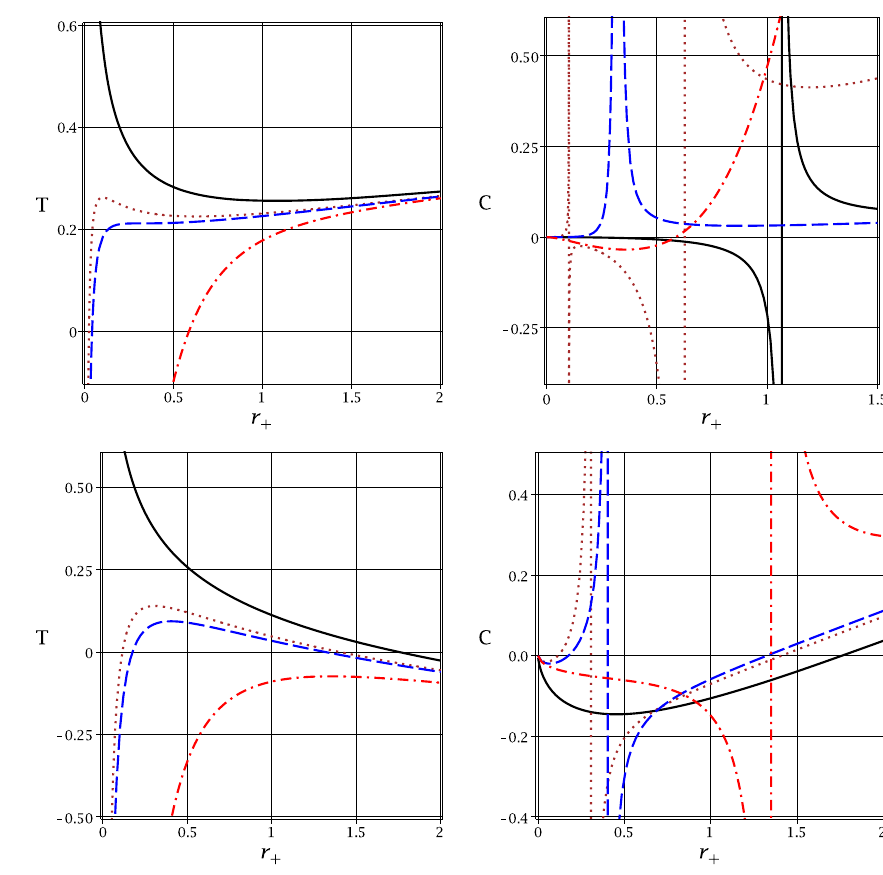
Fig. 6 T (left panels) and C (right panels) versus r + for k = 1, m = 5, (cid:16) = − 1, b = 1, q = 1, f (ε) = g (ε) = 0 . 9, β = 0 (continuous line), β = 0 . 15 (dotted line), β = 0 . 1898 (dashed line) and β = 2. Upper panels: α = 0 . 5; lower panel: α = 1 .